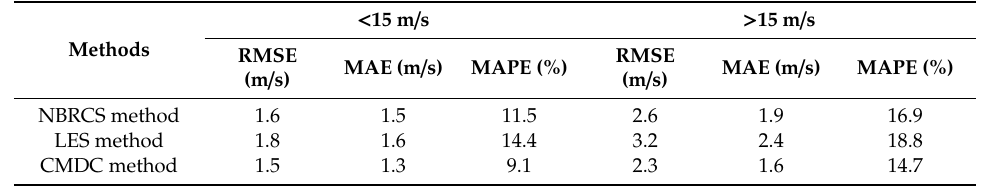
Table 3. The RMSE, MAE, and MAPE of wind speed estimated by NBRCS, LES, and CMDC methods (the wind speed is below and above 15 m /